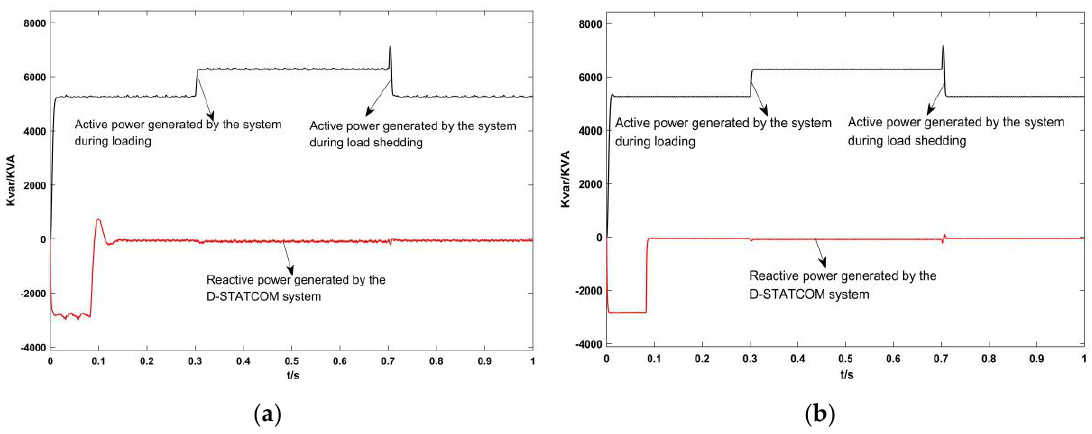
Figure 15. The power generated by the D-STATCOM system. ( a ) The power generated by the D-STATCOM system in traditional LADRC control, ( b ) the power generated by the D-STATCOM system in improved LADRC control.